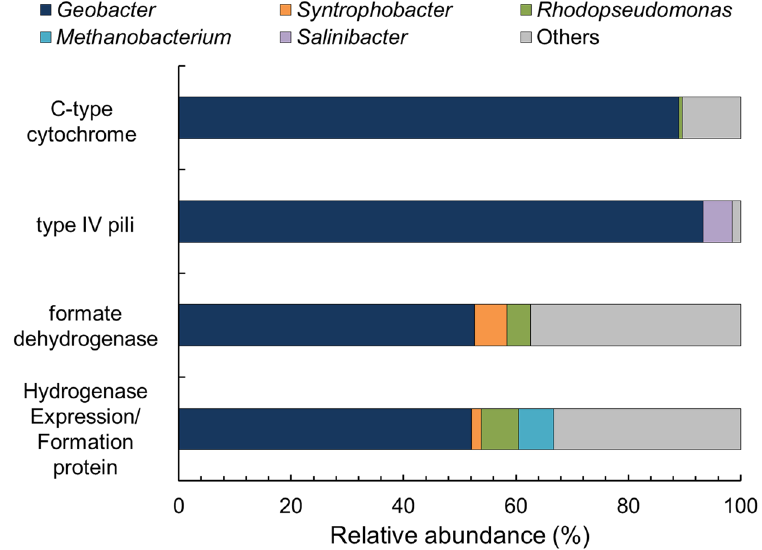
Figure 4. Relative abundances of genes for EET-related enzymes according to taxonomic annotations. The category “Others” indicates genera with relative abundance below